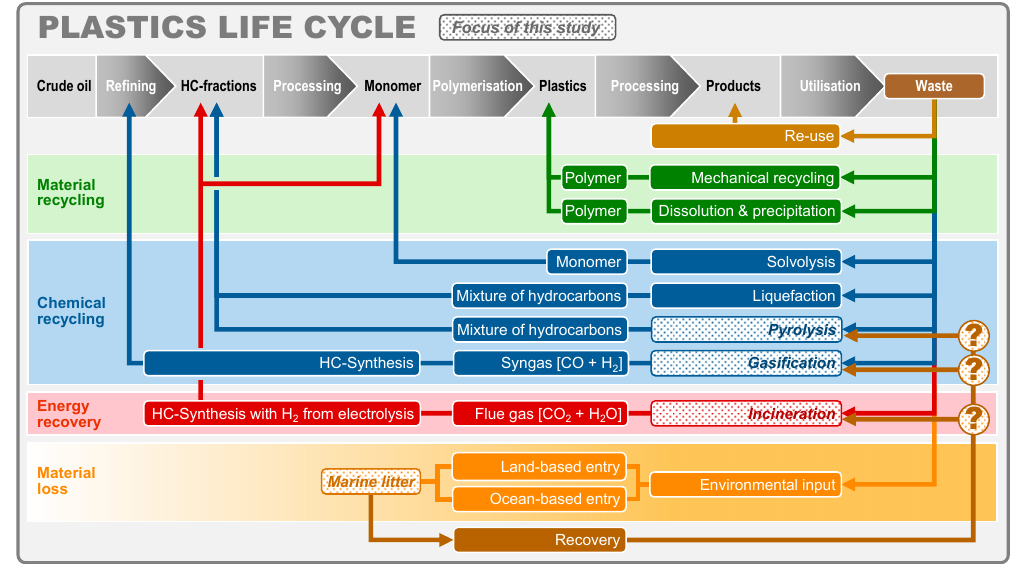
Figure 1. Life cycle of plastics with focus on the investigations of this study. (Figure: Peter Quicker) In terms of environmental input, the figure does not represent the entire life cycle of plastics, which is shown in Reference [3].